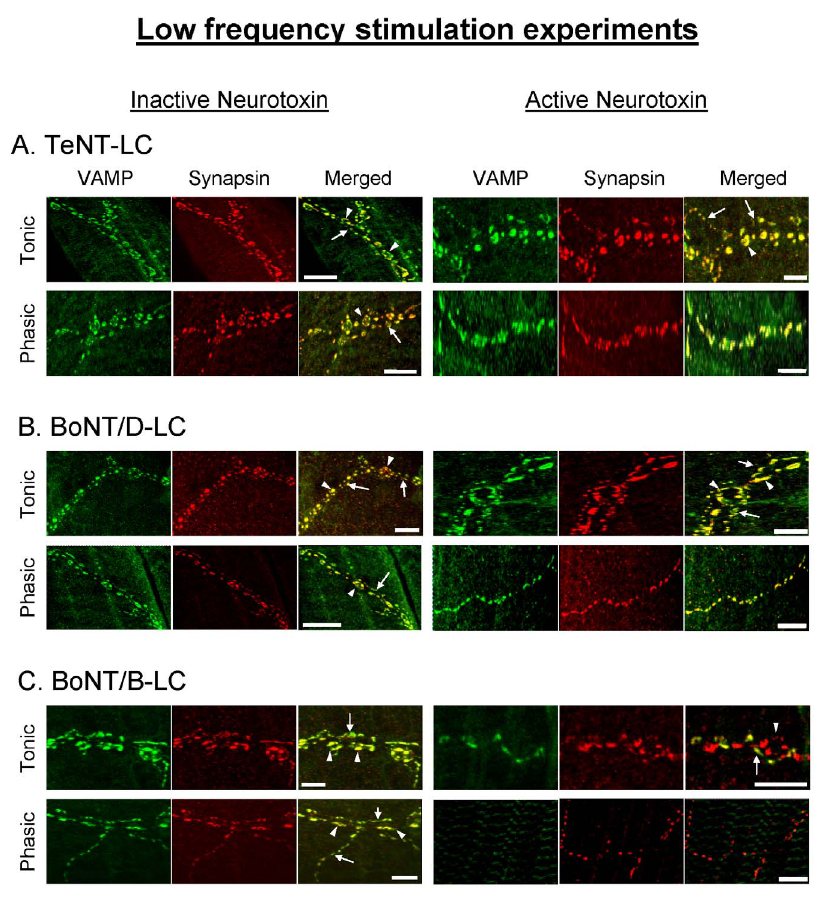
Figure 5. VAMP in phasic and tonic axonal terminals is susceptible only to BoNT/B-LC under low frequency stimulation. Immunostaining of VAMP and synapsin after the injection of inactive and active TeNT-LC ( A ), BoNT/D-LC ( B ) and BoNT/B-LC ( C ) into the phasic or tonic axon during the low frequency stimulation experiments. In A-C , arrows denote phasic terminals and arrow heads denote tonic terminals. The yellow areas in the merged image represent an overlap of VAMP and synapsin immunoreactivity. In C , the injected boutons contain only synapsin indicating that active BoNT/B-LC cleaved VAMP under low frequency stimulation. Note that only active BoNT/B-LC reduced VAMP immunoreactivity under low frequency stimulation conditions. In B , C , no tonic terminals were present in the phasic image with active neurotoxin. Scale bars – A and B : 19 m m; C : 10 m m.